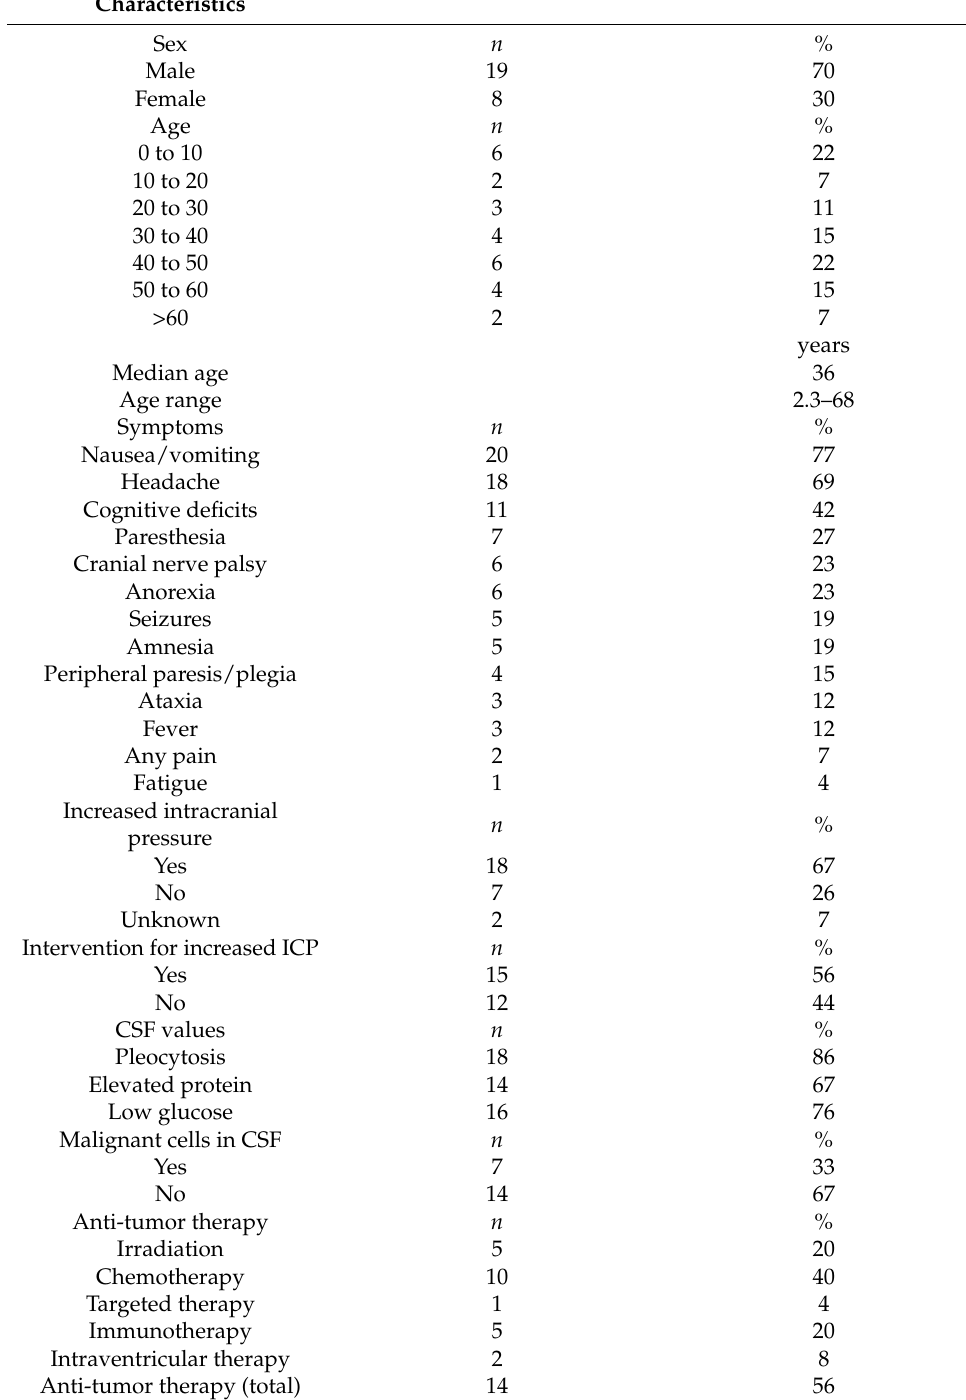
Table 1. Patient